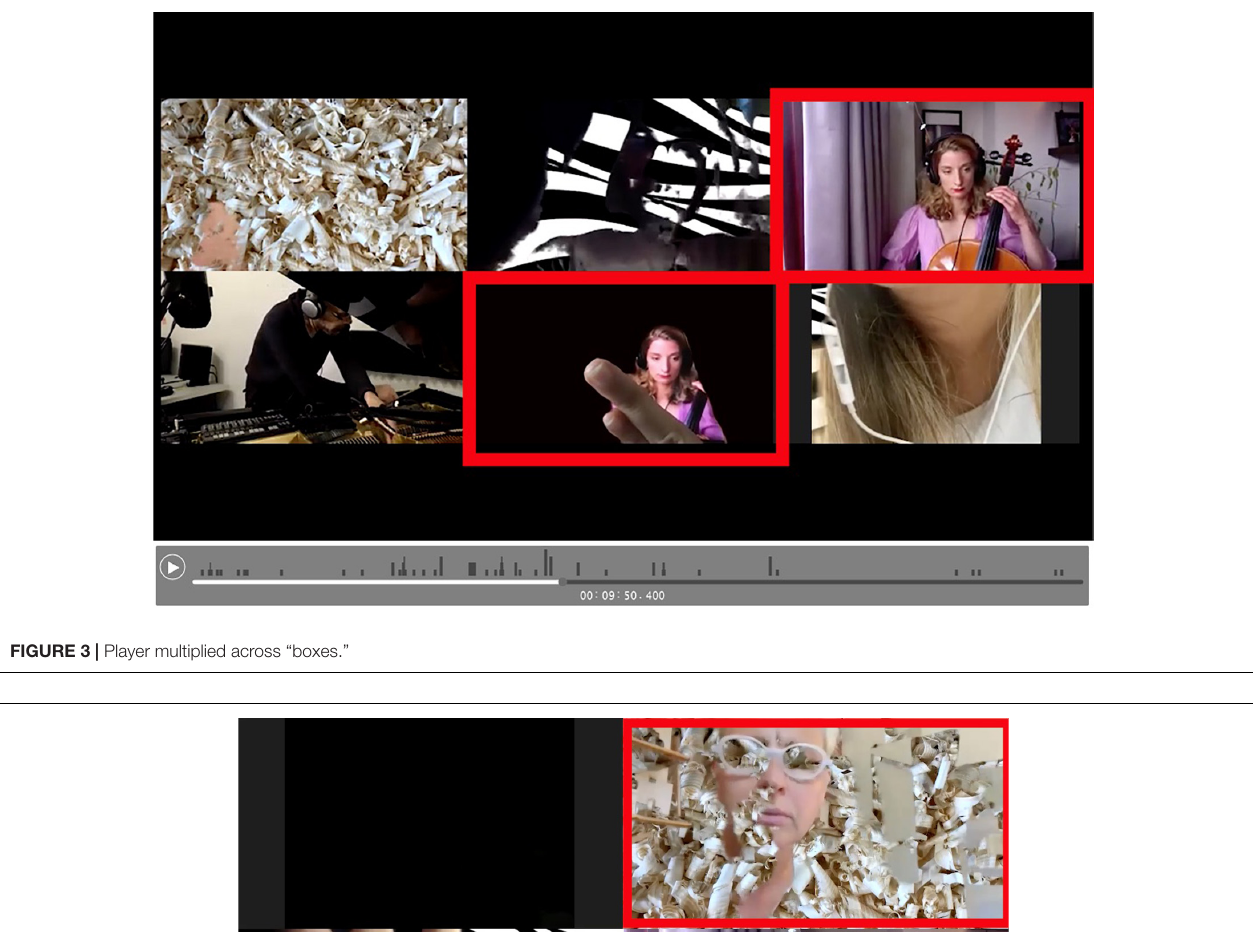
FIGURE 4 | Player hybrid with virtual